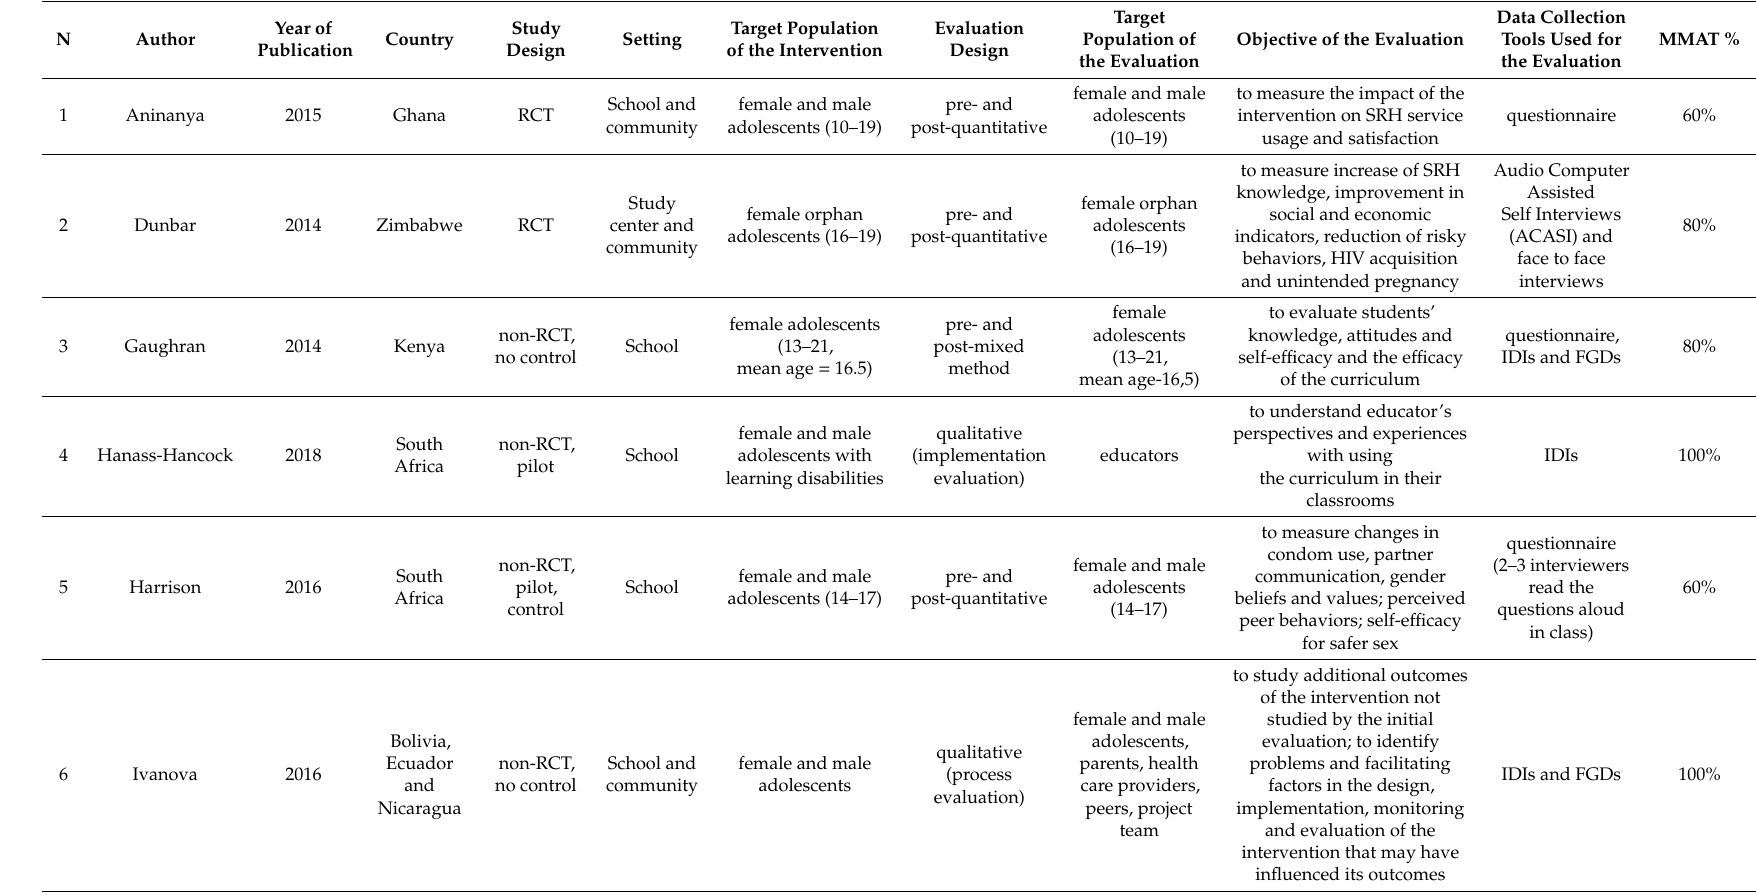
Table 2. Description of studies and evaluation